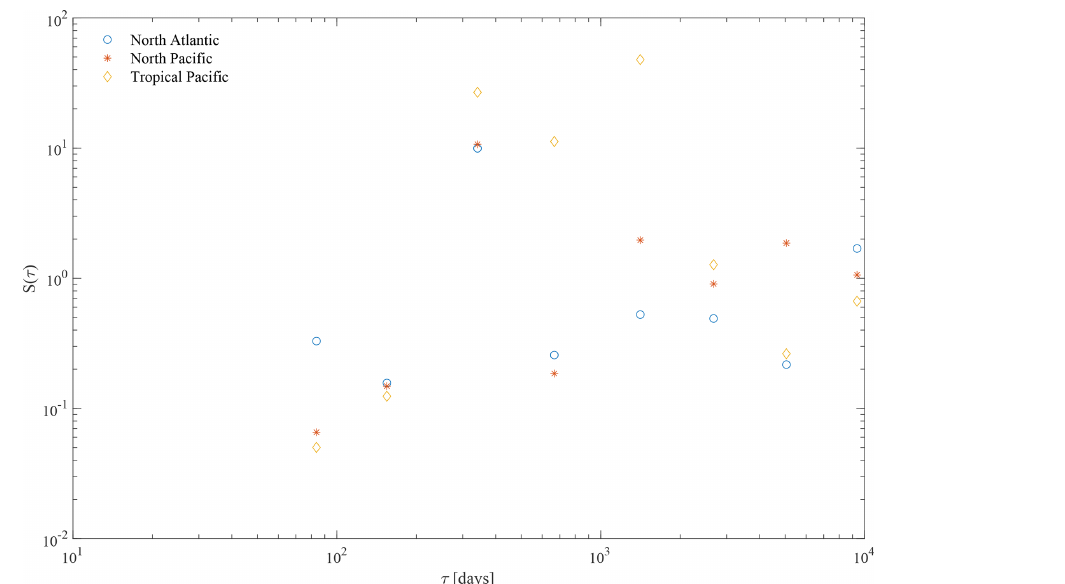
Figure 12. Spectral energy content S ( τ ) of the different MIMFs as a function of their mean timescales τ as in Eq. (7) for the North Atlantic (blue circles), the North Pacific (orange asterisks), and the tropical Pacific (yellow